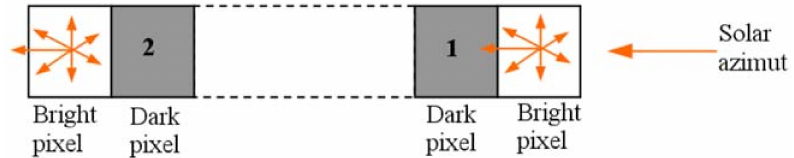
Figure 9. Specular adjacency effect of a bright pixel on a dark pixel according to the position relative to sun